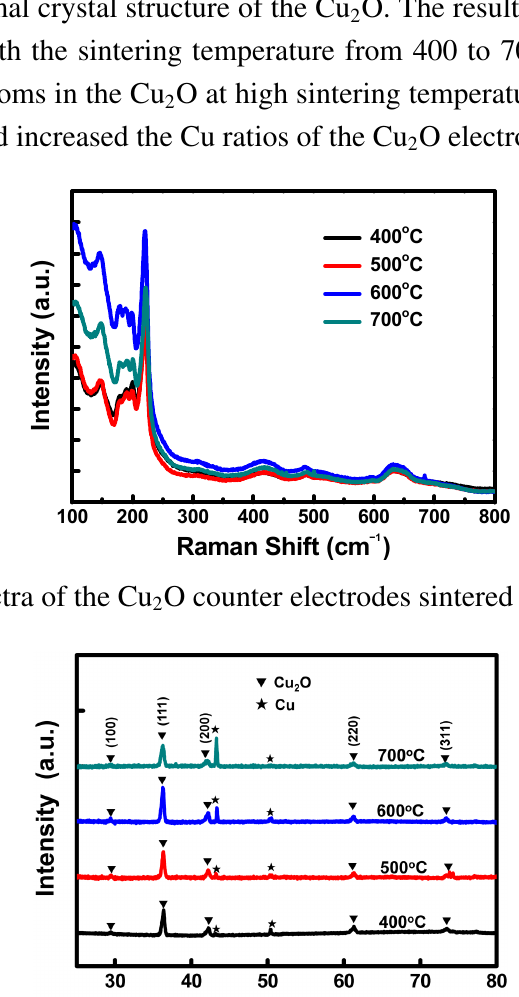
O counter electrodes 2